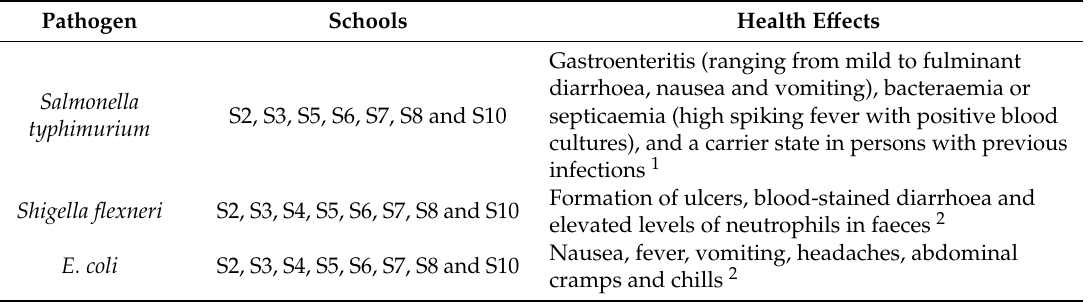
Table 2. Health e ff ects of pathogens in